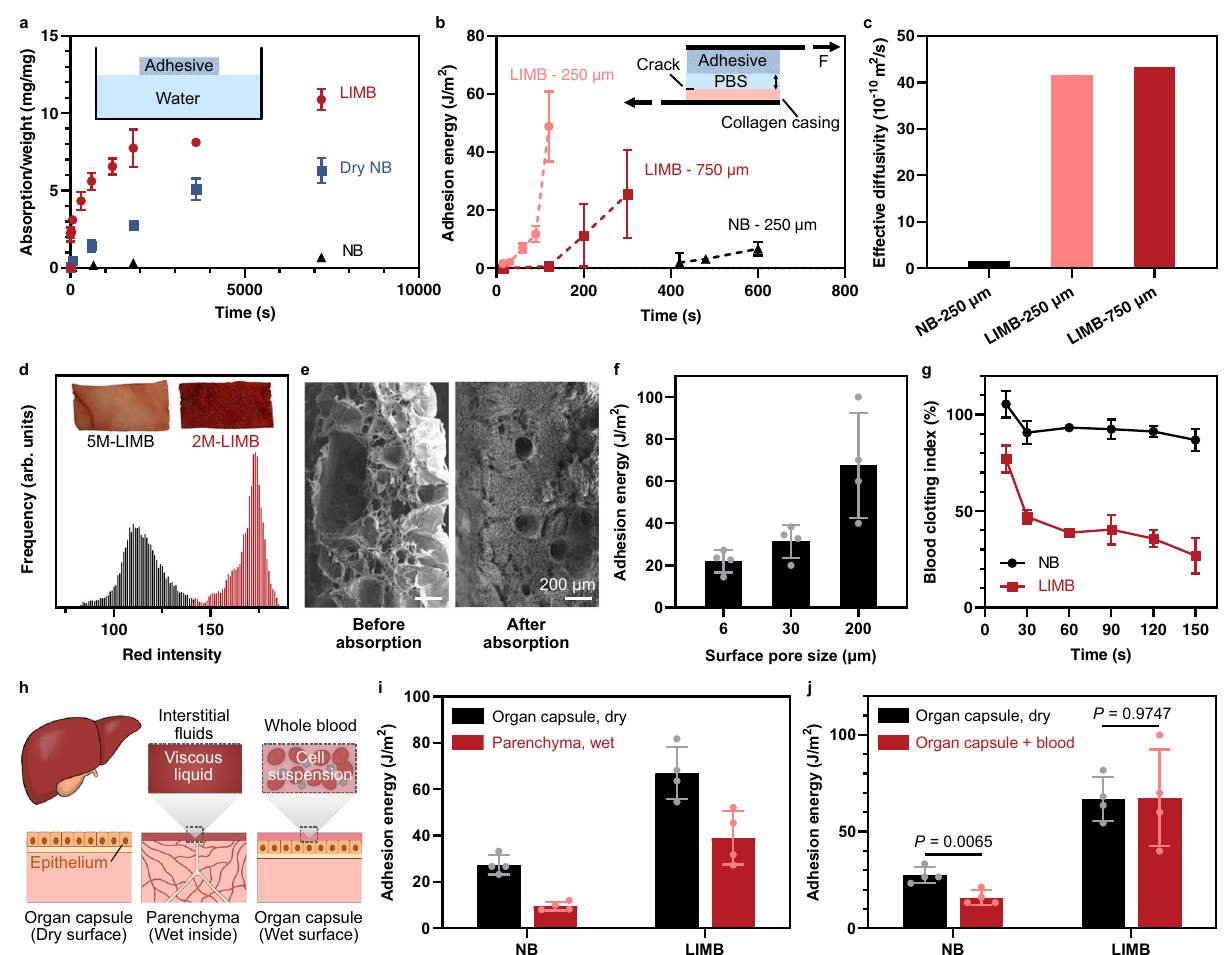
Fig. 2 | Rapid uptake of interfacial fl uids and adhesion on bio-fouled surfaces. a Fluidabsorptionkinetics; b Adhesion formationkinetics. c Effective diffusivityof NB and LIMB. d Digital photos and red-signal distribution showing LIMBs with different surface pore size after absorbing whole blood (inset photos). e SEM images showing LIMB before and after absorbing whole blood. f Adhesion energy on blood-exposure surfaces as a function of the surface pore size. g Clotting kinetics of whole blood placed on LIMB and NB. The lower the index value, the higher the degree of blood clotting. h Schematics showing different wetting